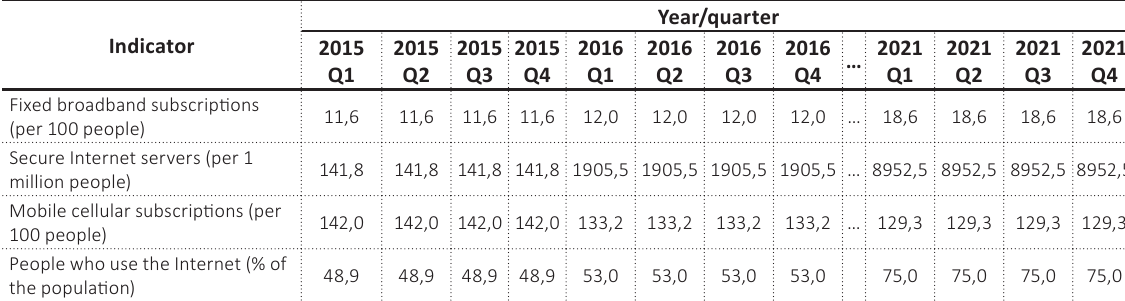
Table А9. Information base for the study of digitization’s general indicators Indicator